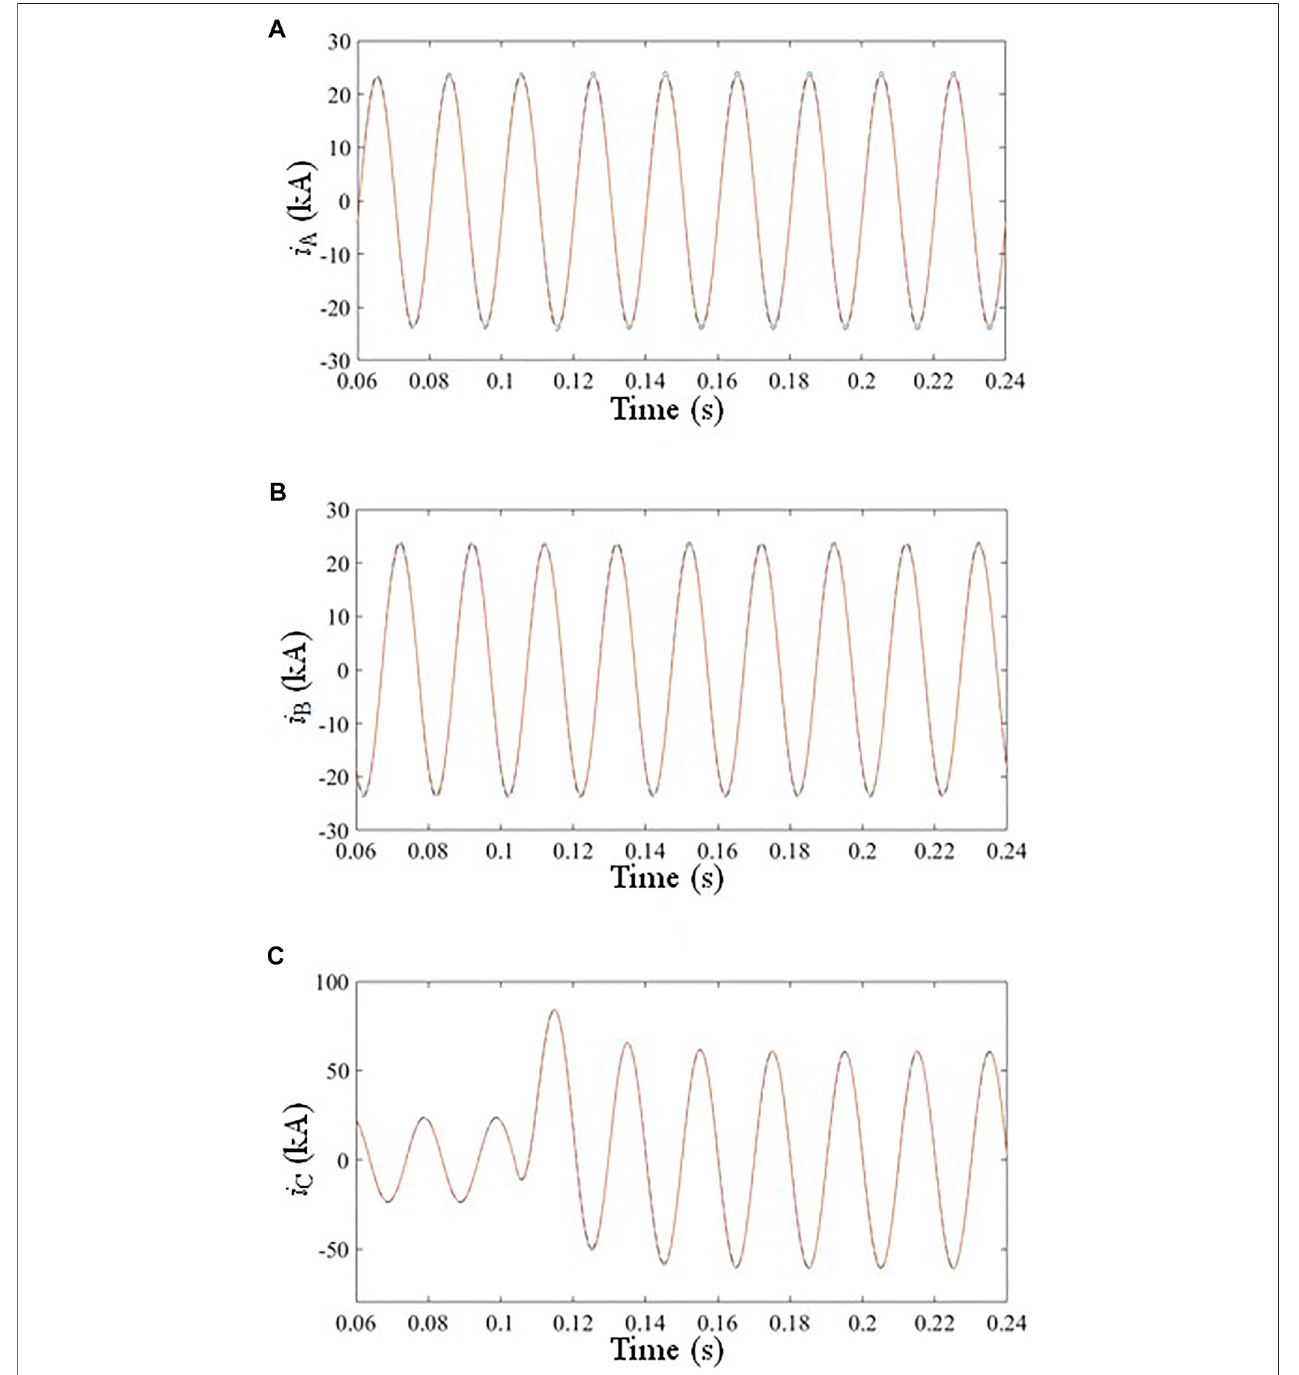
FIGURE8 | Three-phase current waveform on the Nside undera phase Cgrounding fault. (A) Current ofphase A, (B) Current ofphase B, (C) Current ofphase C.